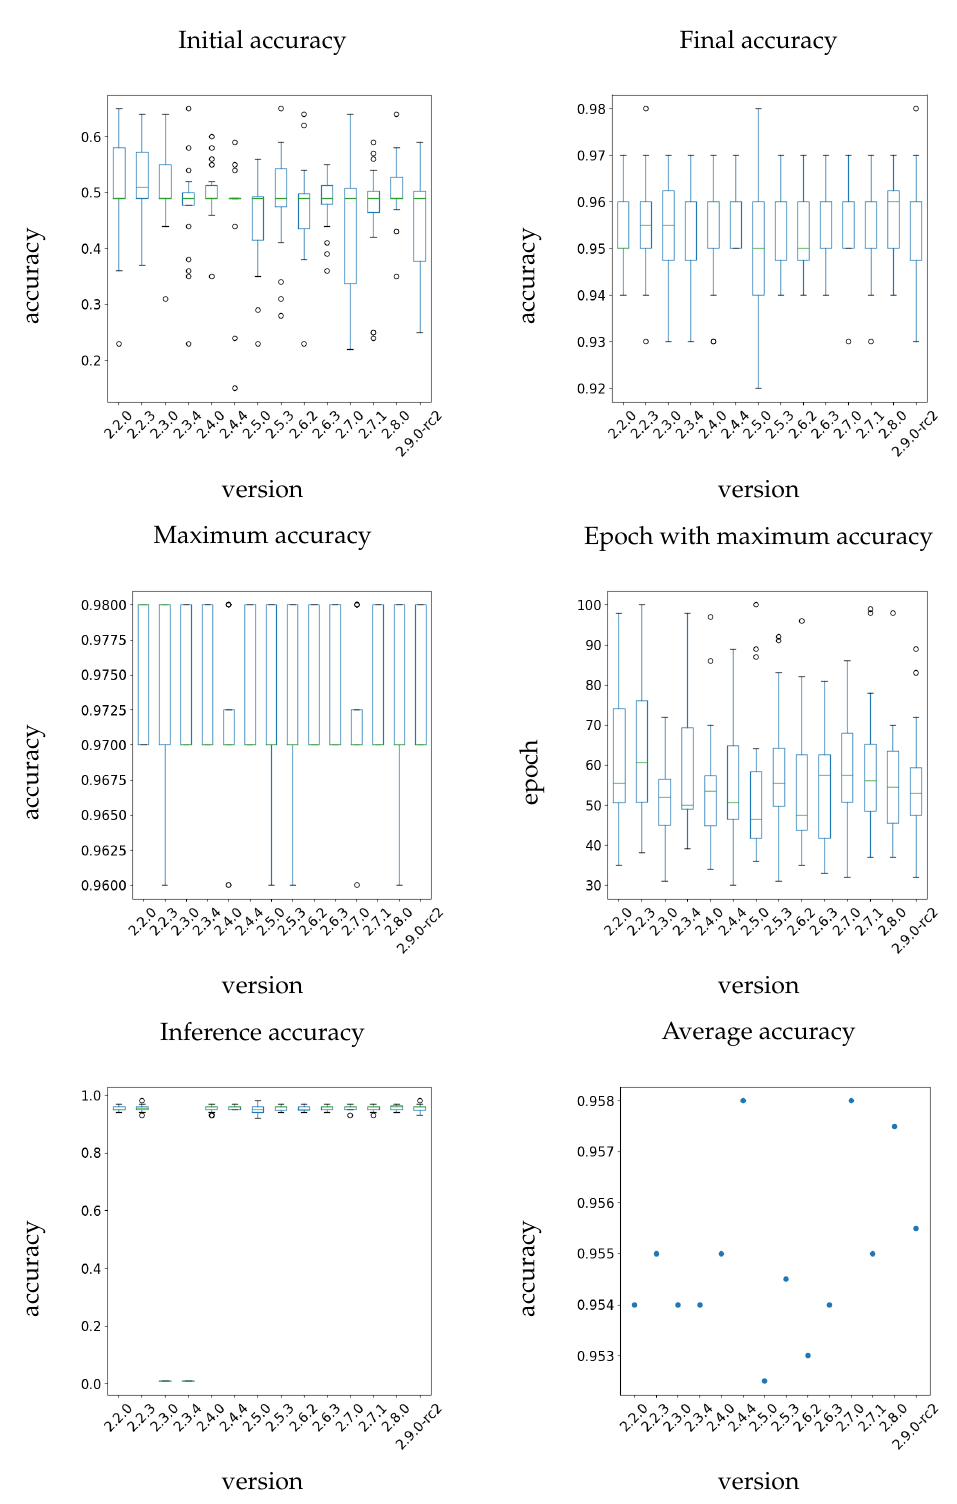
Figure 6. The results for the BMI dataset using